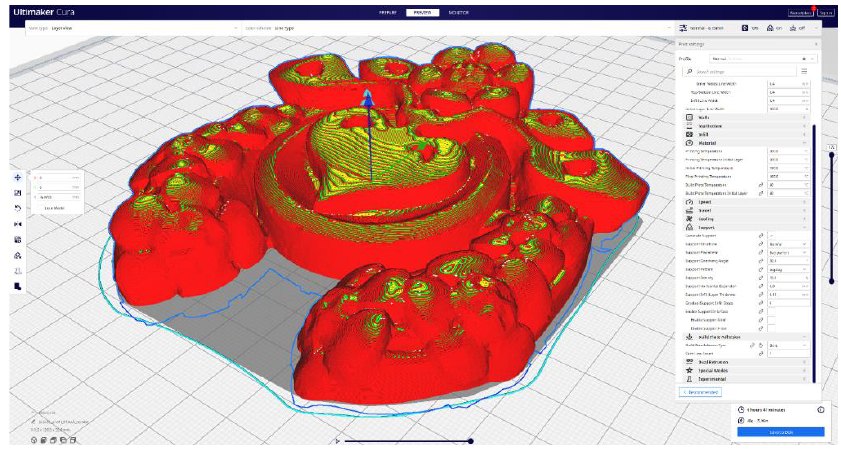
Figure 16. Preparing the G-code before 3D printing one of the ornaments from the Lajos (Ludwig) Besch and Károly (Karl) Piffl Palace.